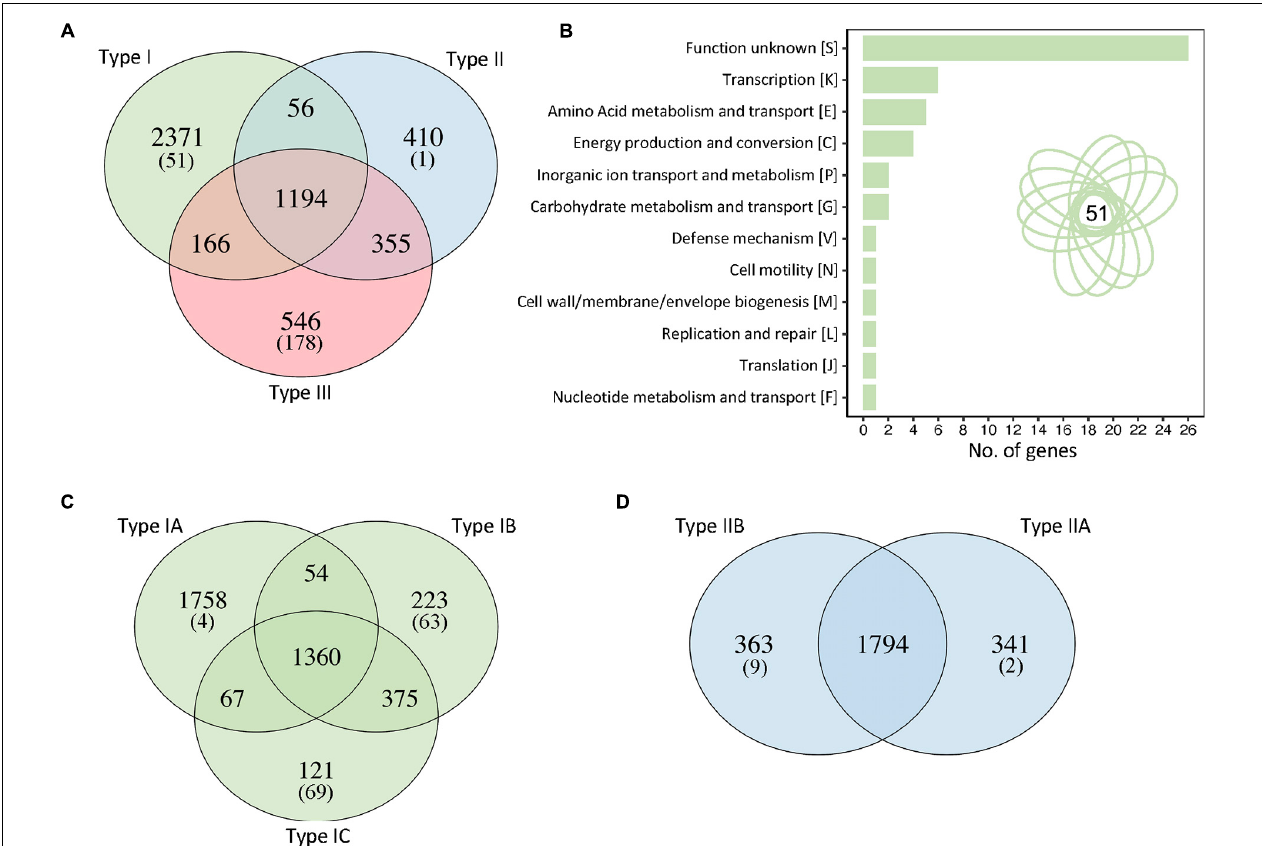
FIGURE 4 | Unique genes in each C. acnes clade. (A) Identification of the number of unique genes for each clade, genes shared by two clades and core genes. The number between brackets represent the number of unique genes present in all the strains of that particular clade. (B) Functional categories of the 51 unique genes present in all type I strains. Manual curation and annotation of these 51 unique genes allowed to elucidate their functionality (see Supplementary Tables 1, 2 ). (C) Unique genes and shared genes within the sub-clades of type I strains. (D) Unique genes and shared genes within the sub-clades of type II